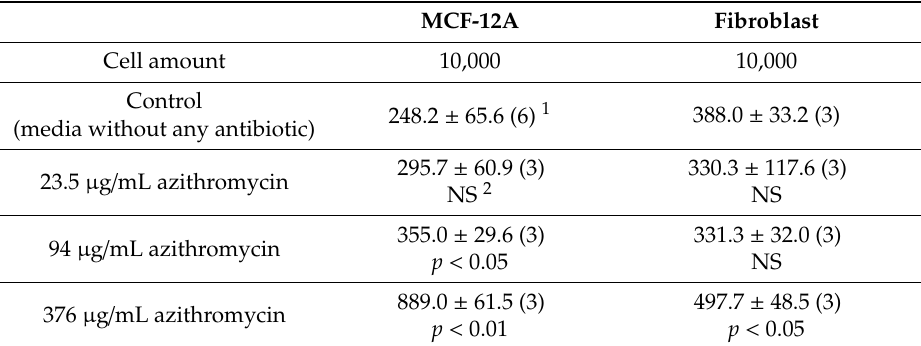
Figure 9. Azithromycin induced oxidative DNA damage in MCF-12A cells and fibroblasts. The details can be seen in the Materials and Methods section. Table 3. Azithromycin caused DNA oxidative damage of MCF-12A cells and fibroblasts. The concentration of 8-HOdG (pg / mL) in the media was measured by the DNA Damage Competitive assay